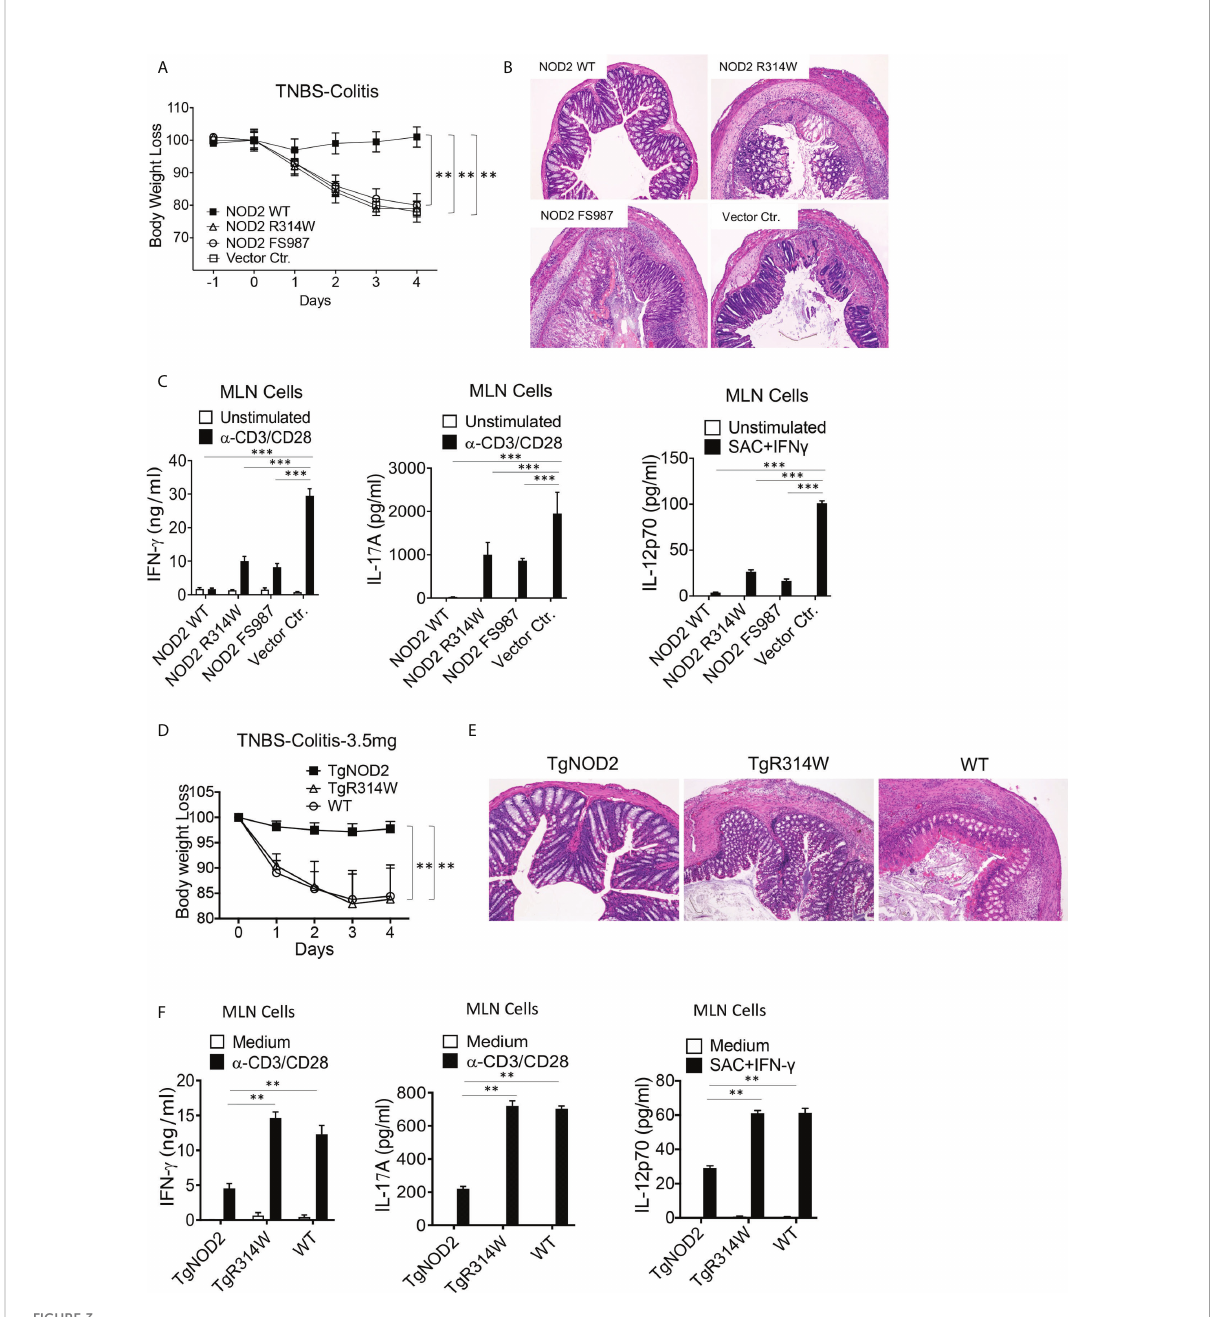
FIGURE 3 Mice with transient over-expression of Blau Syndrome (BS)-associated NOD2 mutation (R314W) or BS-NOD2 transgene are not protected from induction of TNBS-colitis. (A) TNBS-colitis associated weight loss of C57BL/10 mice administered TNBS per rectum (3.5 mg/mouse) on day 0 of study and plasmids expressing intact NOD2 (NOD2-WT), Blau syndrome-associated mutation of NOD2 (NOD2-R314W) or Crohn ’ s disease- associated NOD2 frameshift mutation (NOD2-FS98) encapsulated in HVJ-E or the empty vector control (Vector Ctr) on day -1, day 0 and day 1 of study; mice were harvested for analysis on day 4. (B) Representative histology of colons after H&E staining of tissues from mice harvested on day 4. (C) TCR-induced production of IFN- g , IL-17A and SAC+IFN- g -induced IL-12p70 production by extracted MLN cells from mice harvested on day 4 determined by ELISA. (D) TNBS-colitis associated weight loss of C57BL/10 mice bearing transgenes expressing intact NOD2 (TgNOD2, n=6) or NOD2-R314W (TgBlau, n=7) and wildtype (WT, n=9) mice administered TNBS per rectum (3.5 mg/mouse); mice were harvested for analysis on day 4. (E) Representative histology of colons after H&E staining of colonic tissue from mice harvested on day 4. (F) TCR-induced production of IFN- g and IL-17A by extracted MLN cells harvested on day 4. Data in (A, D) were analyzed using a two-way ANOVA with Dunnett ’ s multiple comparisons. Data in (C, F) were analyzed using a two-way ANOVA with Tukey ’ s multiple comparisons. Data are displayed as mean ± SEM; **p<0.01,